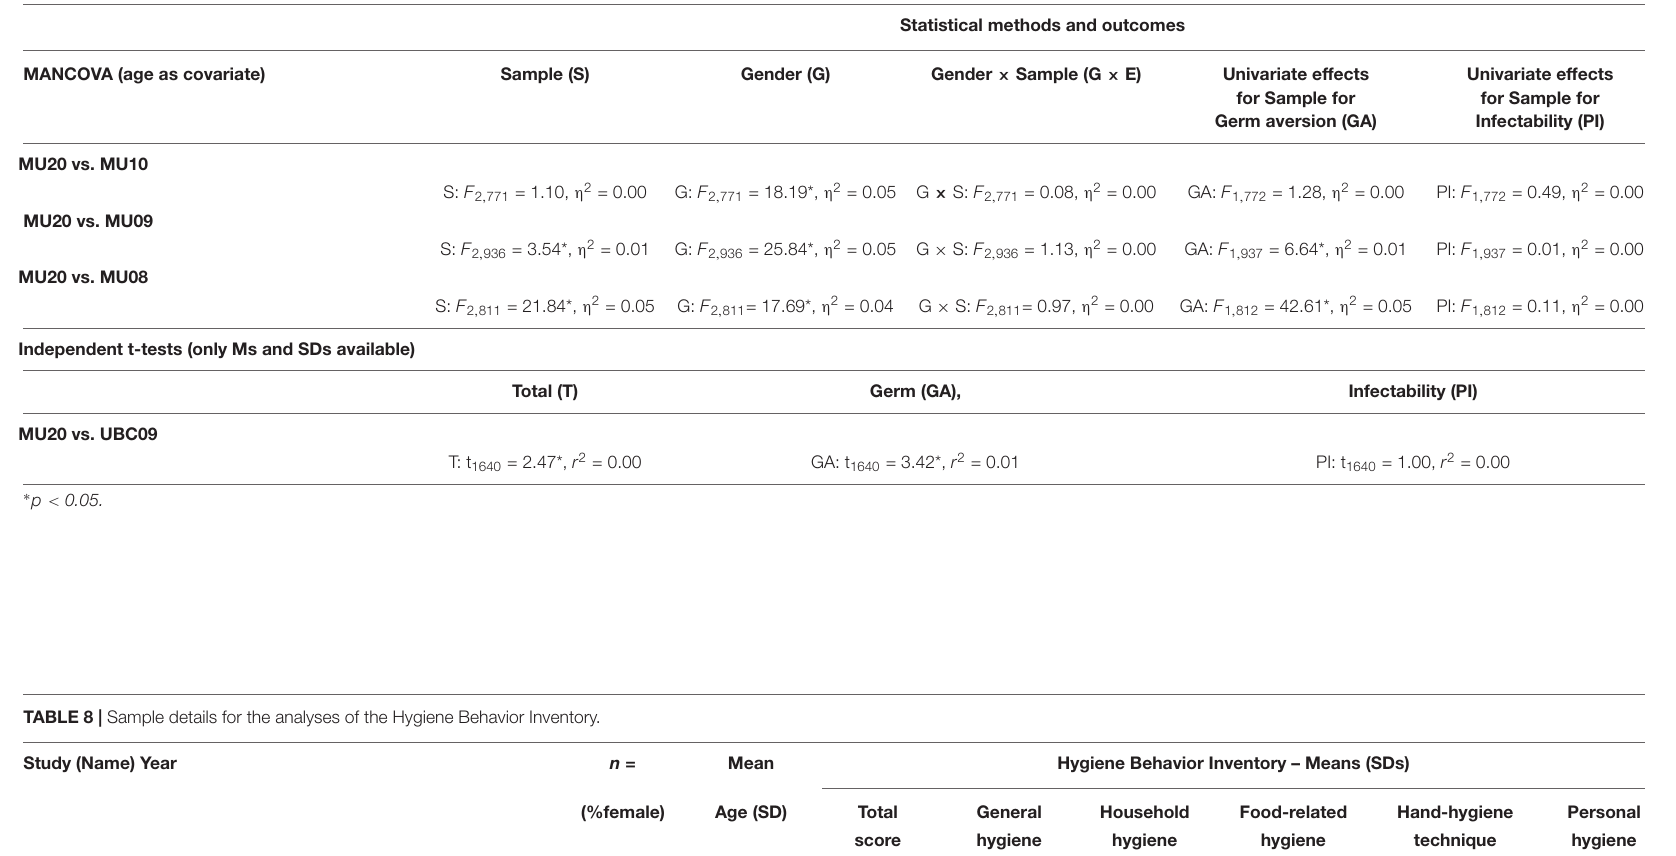
Statistical methods and outcomes